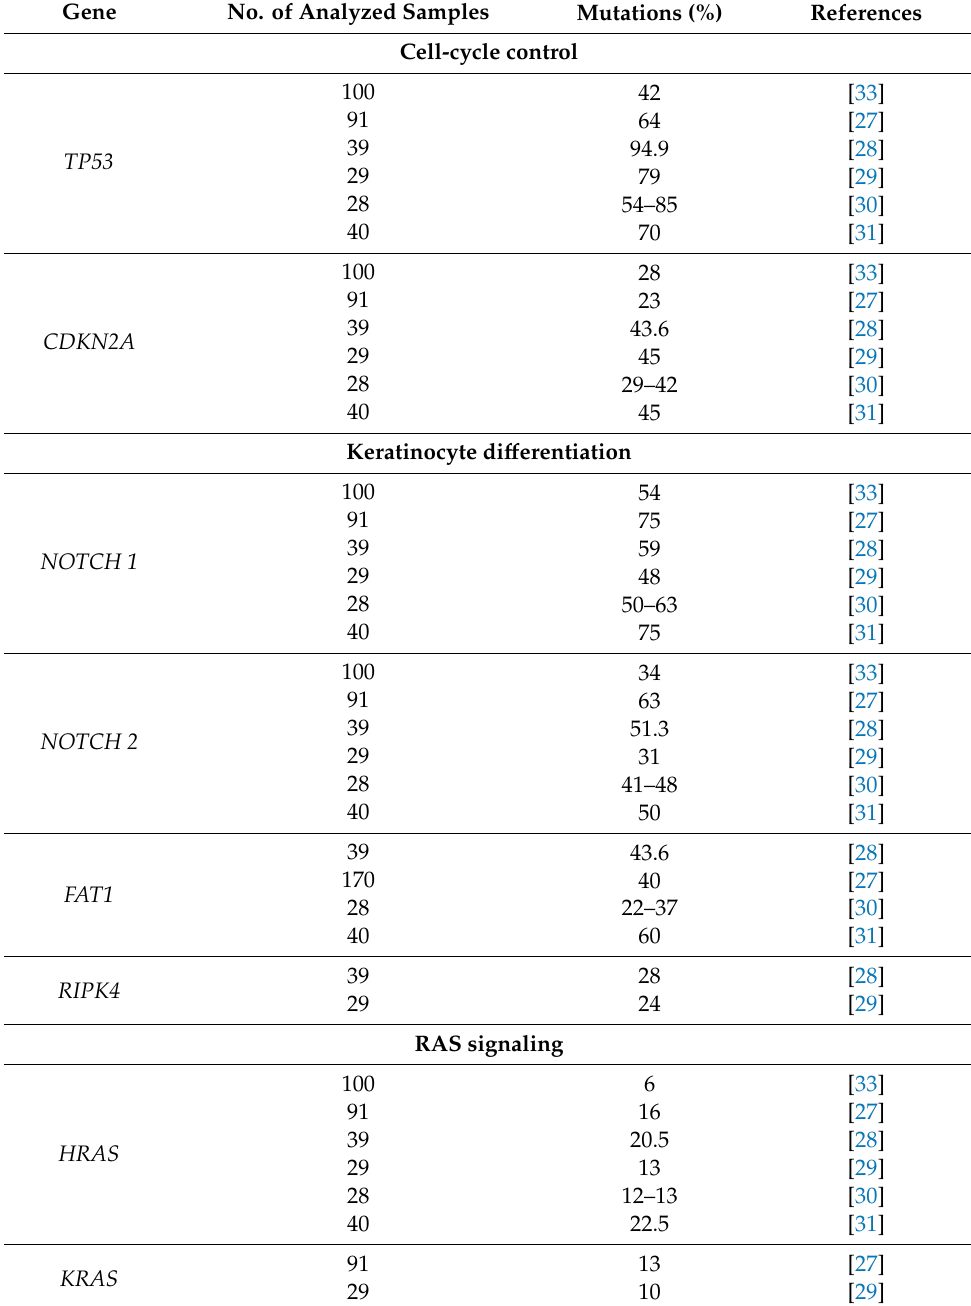
Table 1. Frequency of mutations in cSCC-associated genes across published studies. Gene No. of Analyzed